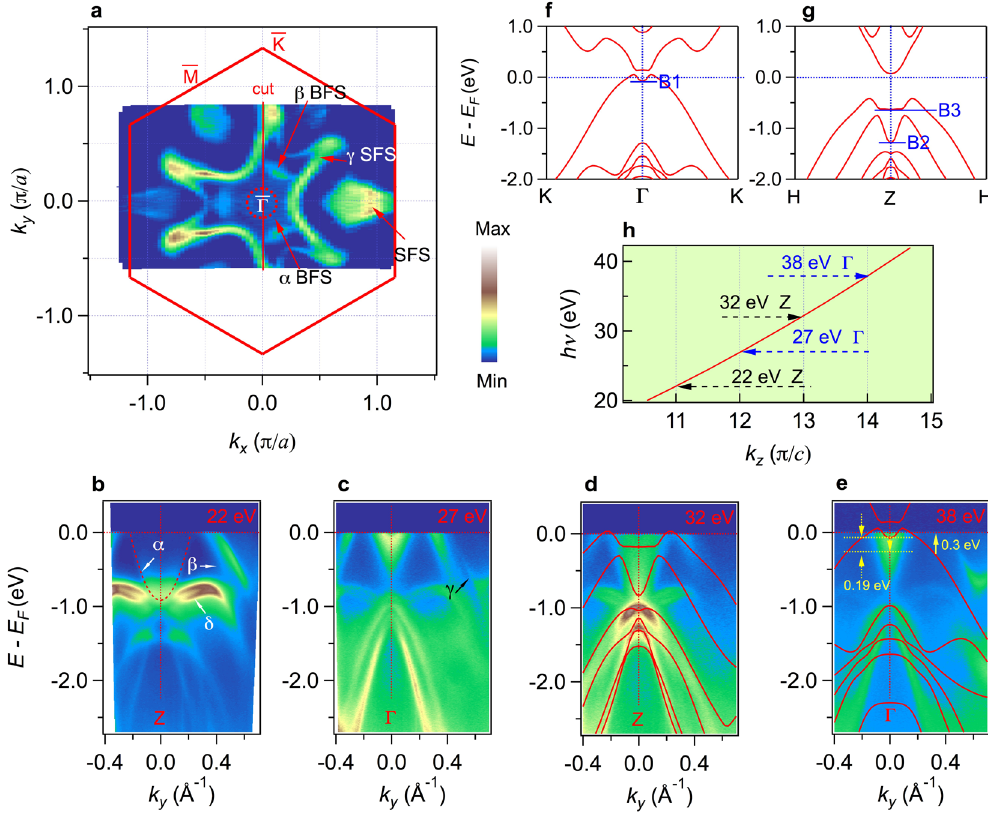
Figure 2. Fermi surfaces and photon energy dependence of band dispersion of SrSn 2 As 2 . ( a ) Fermi surface intensity plot of single crystal SrSn 2 As 2 recorded at hv = 22 eV and T = 25 K with linear horizontal polarization. ( b ) to ( e ) Bands dispersion along cut recorded with different photon energy, respectively. LDA calculated bands are plotted on the experimental data for comparison. ( f ) and ( g ) Calculated bulk band structure along high symmetry line at k z = 0 and k z = π / c , respectively. ( h ) The fitted photon energy curve versus k z